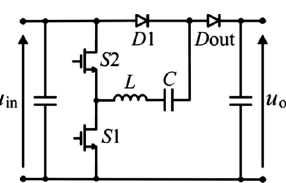
Figure 1. GaN-based resonant switched-capacitor voltage doubler (SCVD) with output voltage range from U in to 2 U in .